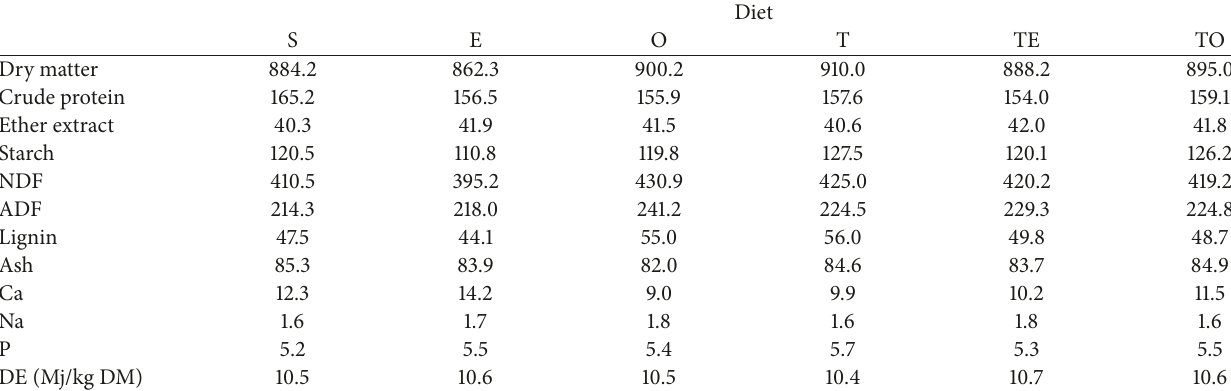
Table 1: Chemical composition (g/kg) of the experimental